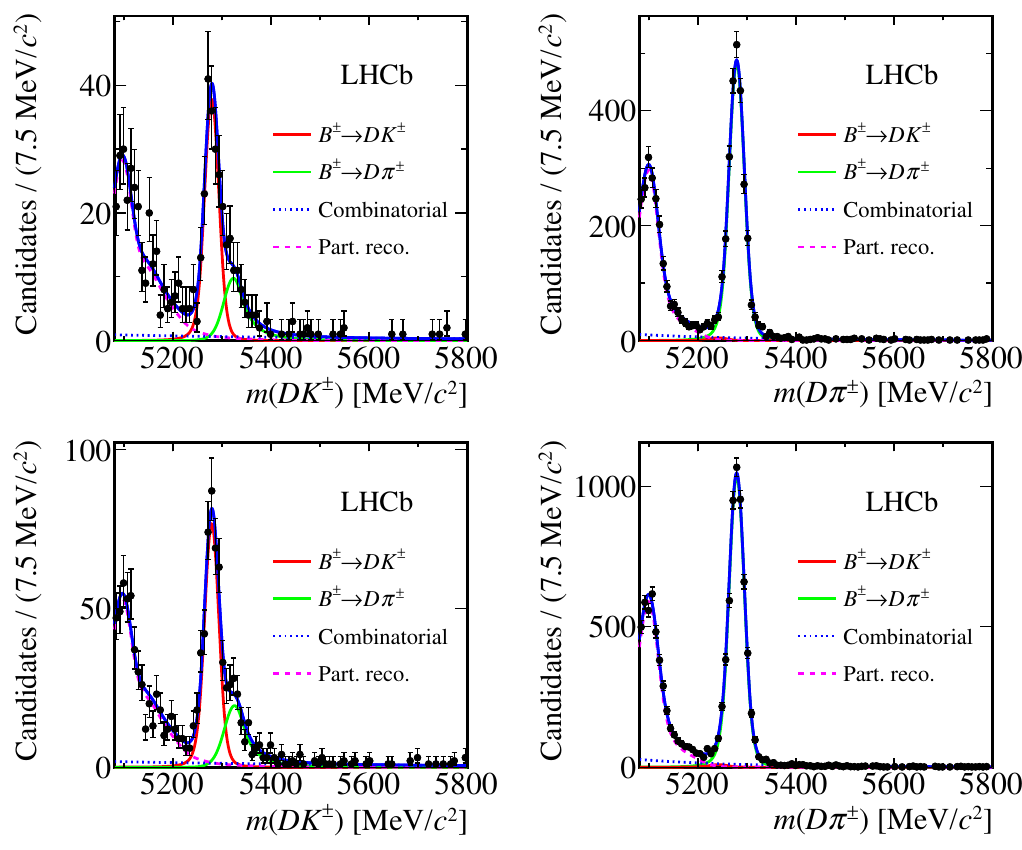
Figure 4 . Invariant-mass distributions of (left) B (cid:6) ! DK (cid:6) and (right) B (cid:6) ! D(cid:25) (cid:6) candidates, with D ! K 0 K + K (cid:0) , shown separately for the (top) long and (bottom) downstream K 0 S Fit results, including the signal component and background components due to misidenti(cid:12)ed com- panions, partially reconstructed decays and combinatorial background, are also